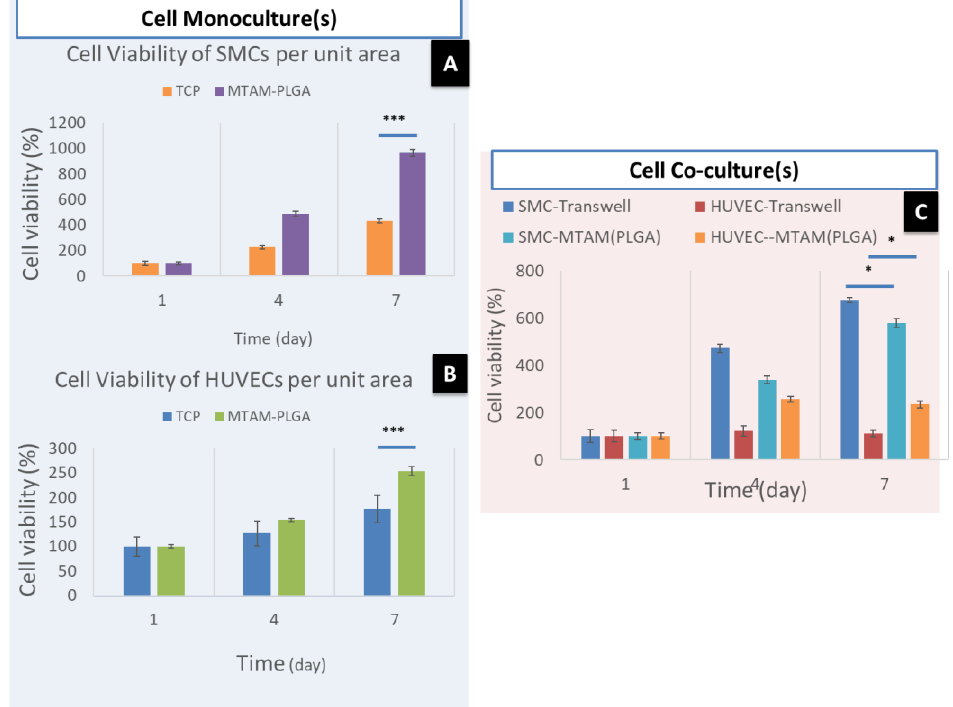
Figure 5. Cell viability test of SMCs and HUVECs ( A ) monoculture of SMCs; ( B ) monoculture of HUVECs; ( C ) co-culture of SMCs and HUVECs (sample size n = 3). * and *** mean